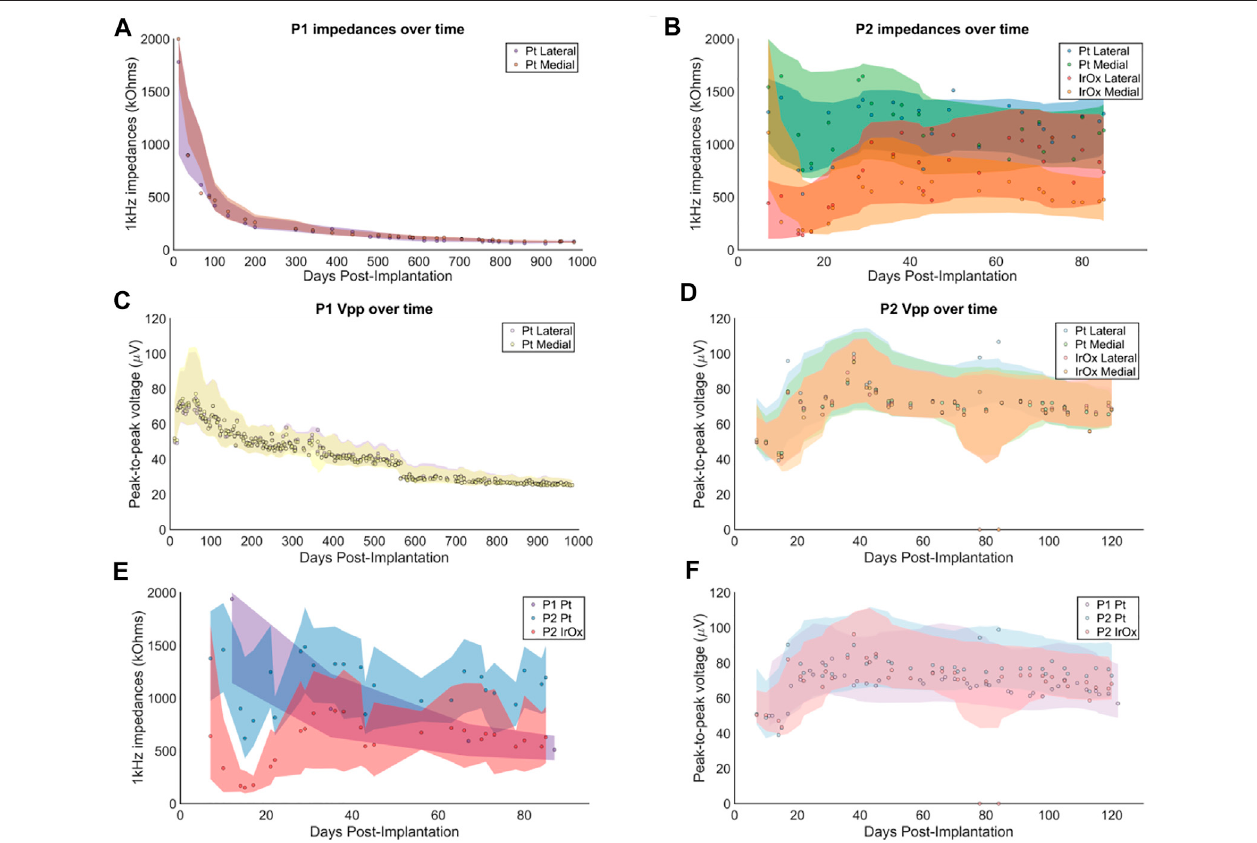
FIGURE 2 | Impedances and peak-to-peak voltages decreased over time. Data points represent the median across electrodes for a given test date. The shaded regions show the interquartile ranges smoothed with a nine-point moving average fi lter with a triangular kernel. Median impedances recorded on (A) P1 electrodes and (B) P2electrodesacrossthelengthofimplant.ImpedancemeasurementsonP1werenotconductedwiththesametemporalresolutionasP2.Differentcolorsrepresent platinum or IrOx for P2 as indicated in the legend. Vpp recorded on (C) P1 electrodes and (D) P2 electrodes across the length of implant. For P1, there was a discontinuity in the Vpp at day post-implant 550 due to a change in the RMS threshold from − 5.25 to − 4.5. Overlayed impedances and Vpp for P1 and P2 are shown in (E) and (F) , respectively.